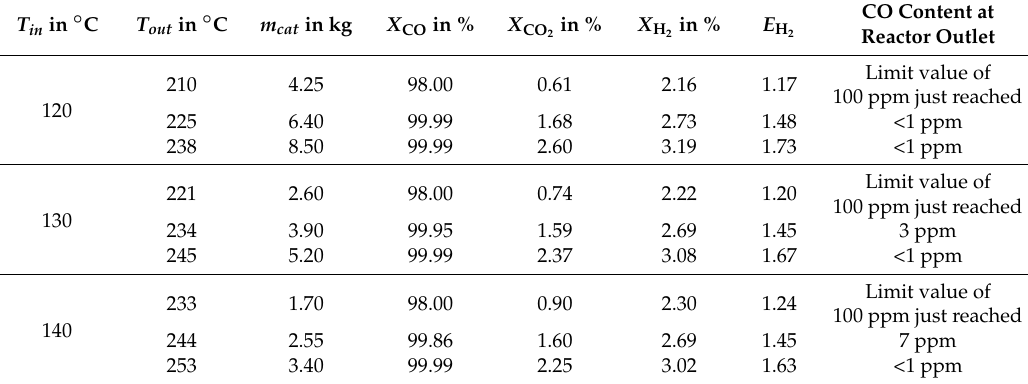
Figure 10. Temperature and conversion profiles of an adiabatic fixed-bed reactor for inlet temperatures of 120 °C, 130 °C and 140°C (971 l h − 1 (STP), feed gas: 0.5% CO, 10% CO 2 , 10% H 2 O, 79.5% H 2 ). Table 4. Basic data of an adiabatic reactor for selective CO-methanation for three different initial temperatures.